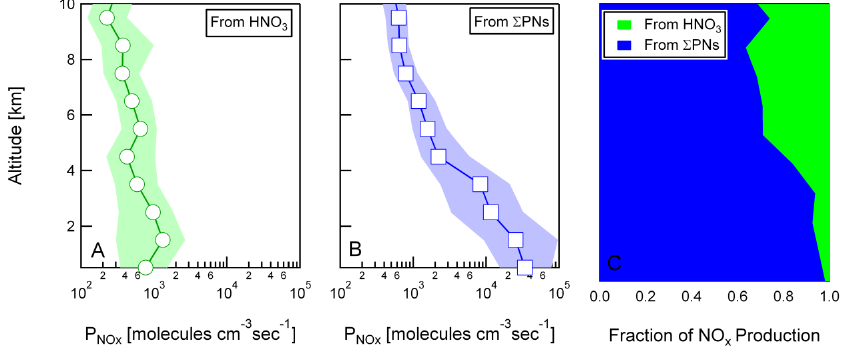
Fig. 6. Diurnally averaged NO x production rates (moleculescm − 3 s − 1 ) from nitric acid (left) and 6 PNs (centre) as a function of altitude. The fraction of NO x production from each channel is shown in the right panel. Observations were filtered to remove strong stratospheric influence (O 3 /CO > 1.25) and are for the northern pacific (Latitude > 35 ◦N).